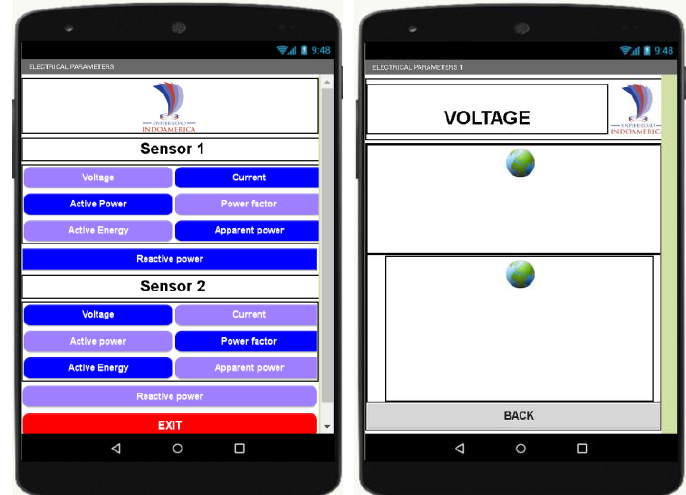
Figure 8. User interface design for mobile application.